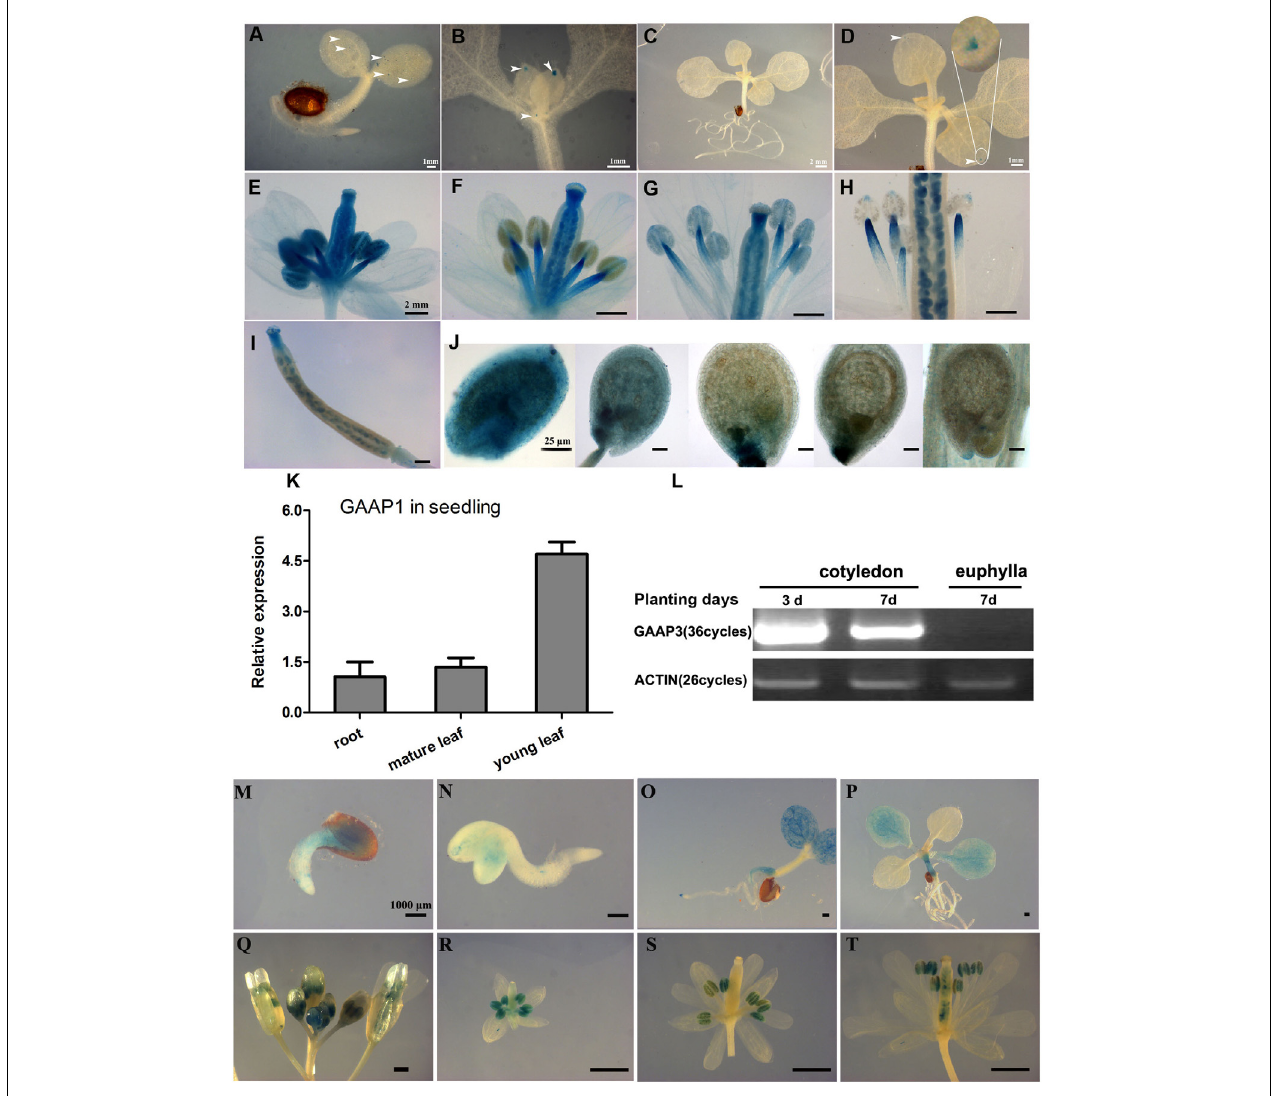
FIGURE 2 | Expression patterns of GAAP1 and GAAP3 in Arabidopsis. GUS staining of GAAP1 in 3-day-old seedling (A) , in the above-ground area of 7-day-old seedling (B) , in a 10-day-old seedling (C,D) , in the development of the flower (E–H) , in a young silique (I) , and in the development of seeds (J) . The arrowhead indicates the staining signal, and the encircled region in (D) is magnified. Bars = 1 mm (A,B,D) , 2 mm (C,E–I) , and 25 µ m (J) . (K) Expression pattern of GAAP1 genes in 7-day-old seedlings assayed by q-PCR. Data are represented at the fold level relative to the level in the root. (L) Expression pattern of GAAP3 genes in young seedlings assayed by RT-PCR. GUS activity of GAAP3 during seed germination (M,N) , in 4- and 14-day-old seedlings (O,P) , in the whole inflorescence (Q) , in the development of flower at stage 7–9 (R) , stage 10–12 (S) , and stage 13 (T)